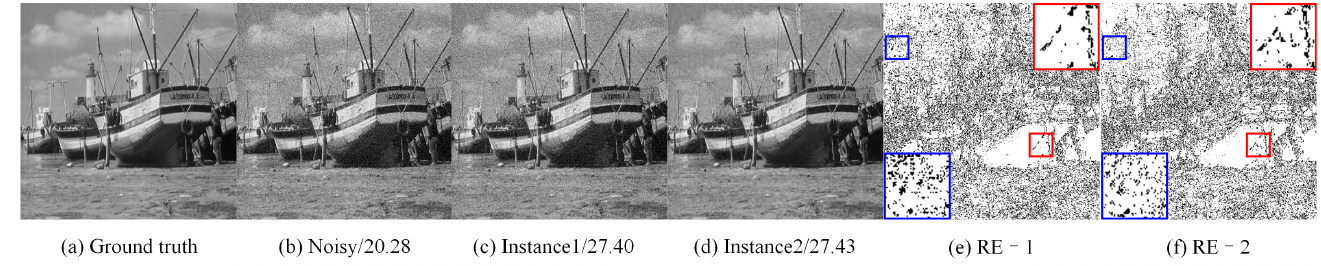
Figure 3. Visual comparison of the denoised instances generated from two different DIP optimization processes. The quantitative PSNR results are listed behind the noisy image and two instances.